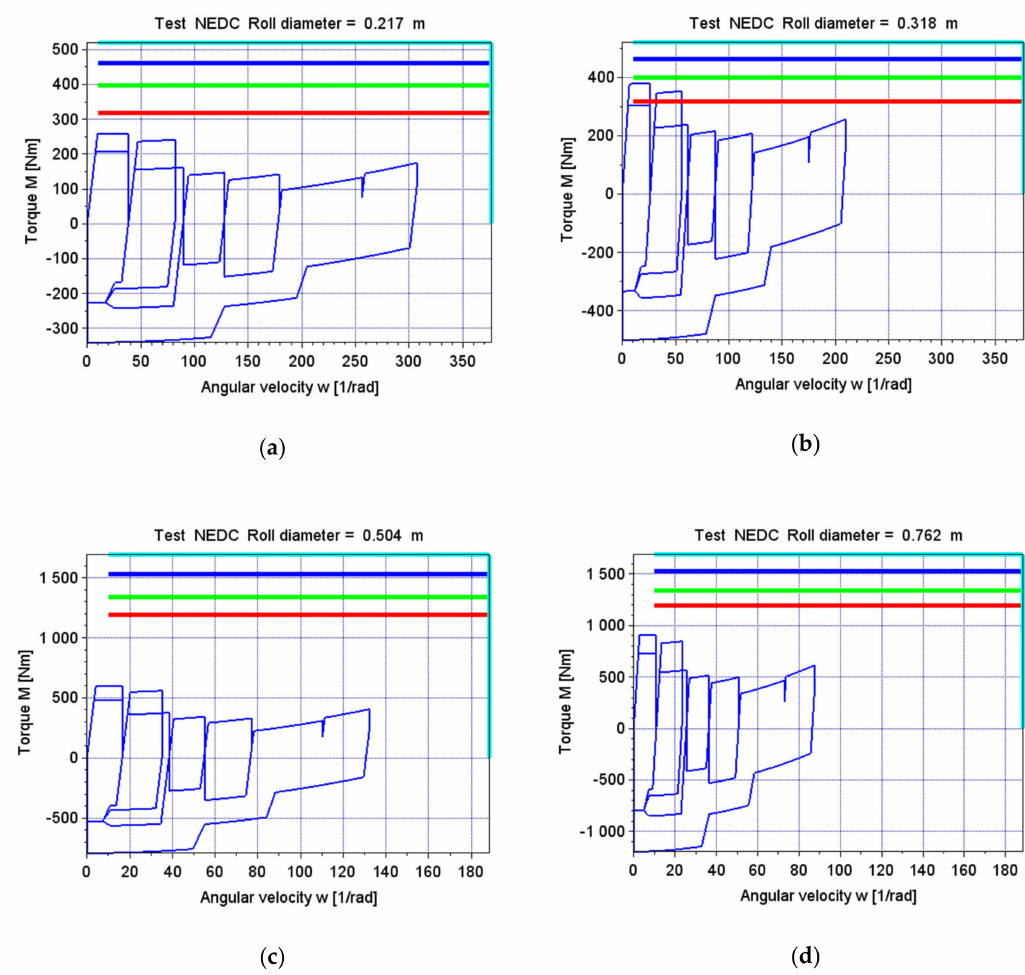
Figure 8. Simulation results for the NEDC test in the form of rotational speed and torque of the chassis dynamometer brake for changes in the diameter of the brake rollers: ( a ) 0.217 m—ECP 34-1S / 2—Power 120 kVA red line; ECP 34-2S / 2—Power 150 kVA green line; ECP34-1L / 2—Power 174 kVA blue line; ECP 34-2L / 2—Power 196 kVA light blue line; ( b ) 0.318 m—ECP 34-1S / 2—Power 120 kVA red line; ECP 34-2S / 2—Power 150 kVA green line; ECP34-1L / 2—Power 174 kVA blue line; ECP 34-2L / 2—Power 196 kVA light blue line; ( c ) 0.504 m—ECO38 1S4 A—Power 225 kVA red line; ECO38 2S4 A—Power 253 kVA green line; ECO38 3S4 A—Power 289 kVA blue line; ECO38 1L4 A—Power 319 kVA light blue line; ( d ) 0.762 m—ECO38 1S4 A—Power 225 kVA red line; ECO38 2S4 A—Power 253 kVA green line; ECO38 3S4 A—Power 289 kVA blue line; ECO38 1L4 A—Power 319 kVA light blue